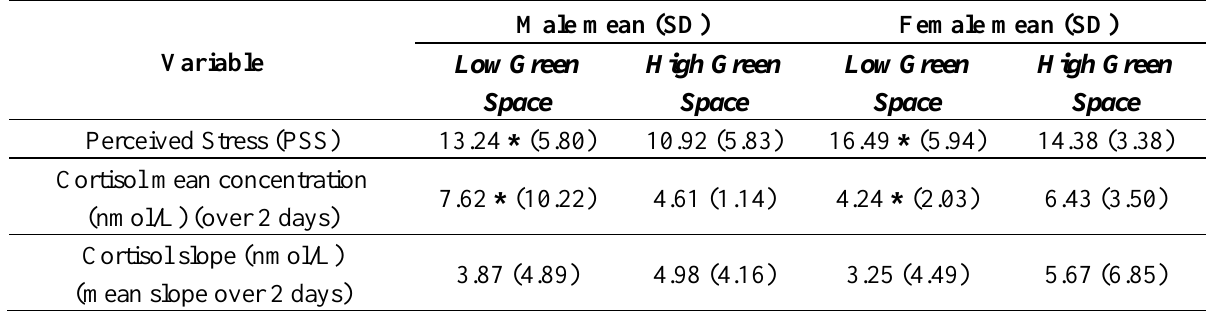
Table 3. Gender differences in stress levels by level of green